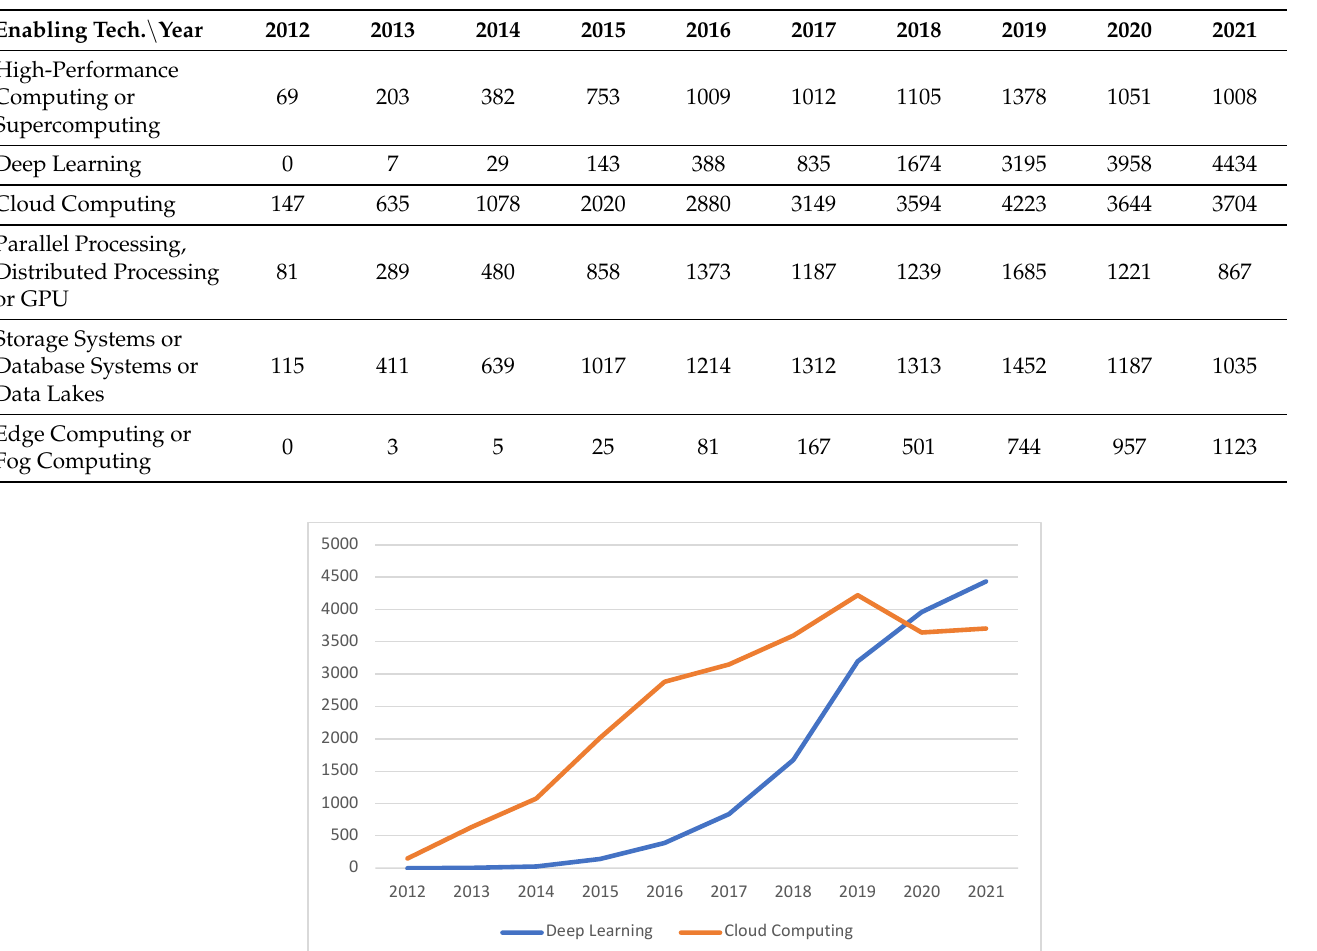
Table 3. The number of research publications per year for the six enabling technologies for Big Data that we identified.